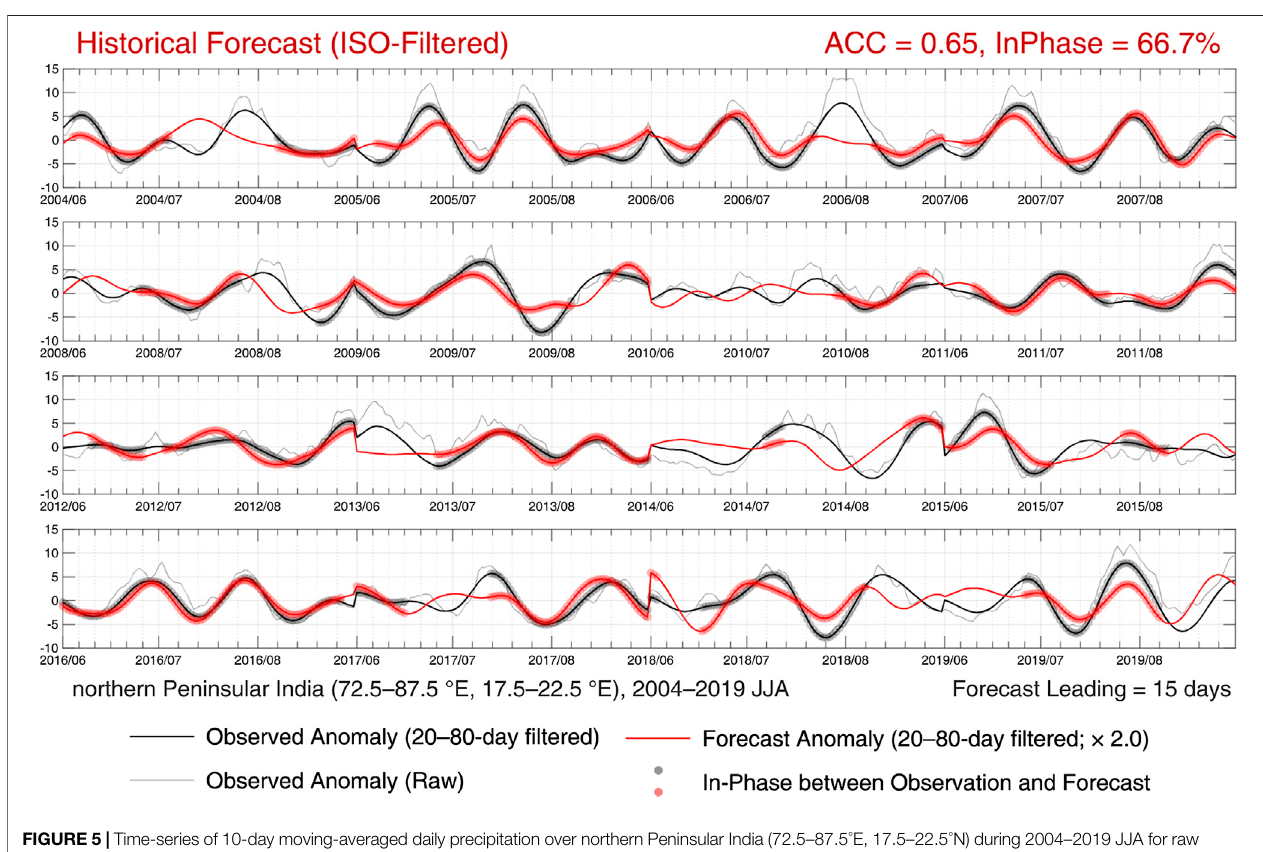
FIGURE 5 | Time-series of 10-day moving-averaged daily precipitation over northern Peninsular India (72.5 – 87.5 ° E, 17.5 – 22.5 ° N) during 2004 – 2019 JJA for raw observational anomalies (thin-gray lines), 20- to 80-day VMD- fi ltered observational anomalies (thick-black lines), and 20- to 80-day VMD- fi ltered forecast anomalies made at a lead time of 15 days in advance (thick-red lines). Points marked by circles indicate that the 20- to 80-day observational and forecast anomalies are instantaneouslyinphasewitheachother.Theratioofin-phaseis66.7%overtheentireperiod,andtheiranomalycorrelationis0.65(denotedonthetop-rightcorner by “ In-phase ” and “ ACC, ” respectively). The forecast time-series has been multiplied by a fi xed factor of 2.0 to compensate the systematic underestimation of the amplitude. The discontinuities between 2 years should be ignored.